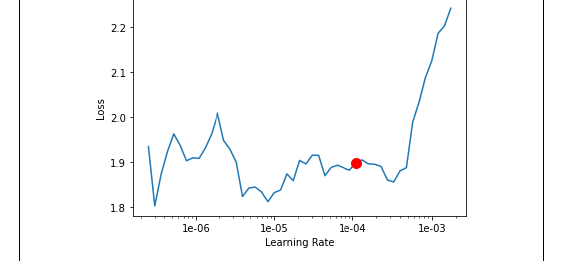
Figure 14. Learning rate of the model